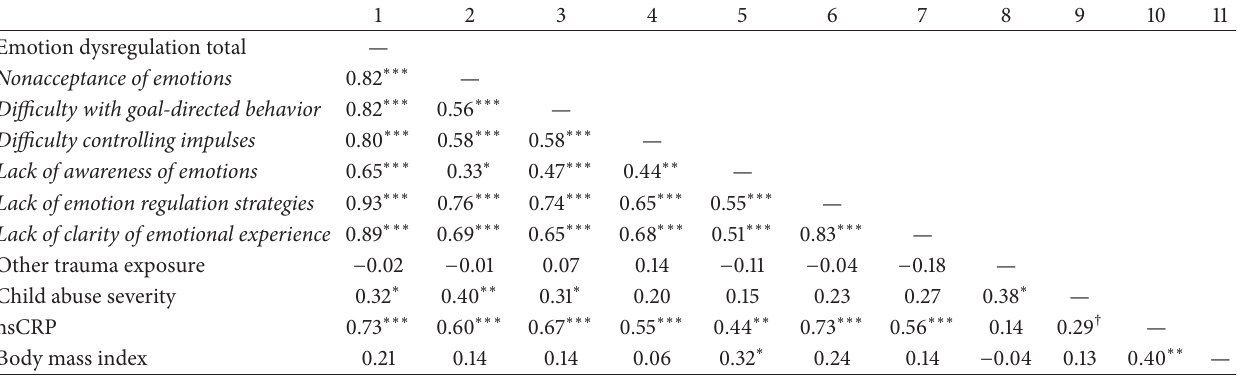
Table 2: Bivariate Pearson’s correlations ( 𝑟 ) between variables of interest.